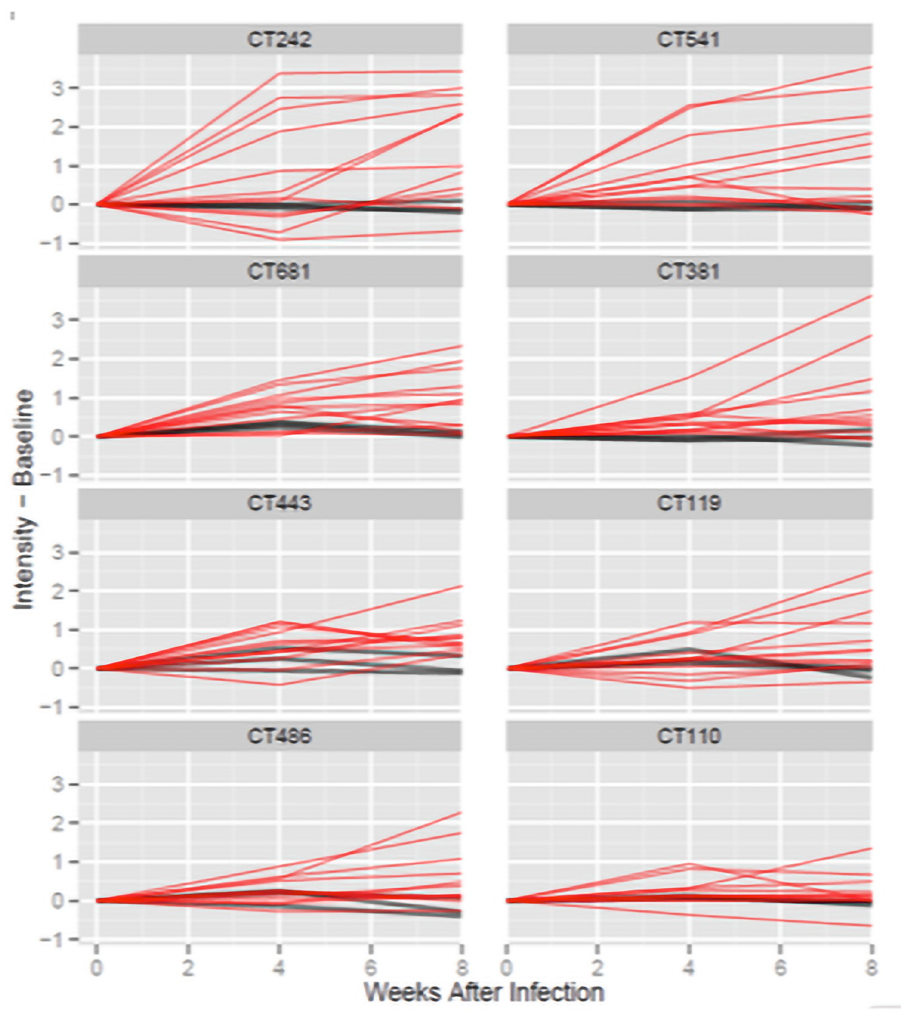
Fig 3. Time course of antibody responses from week 0 to week 8. Each panel presents the time course of antibody responses for all 15 monkeys for one reactive antigen. The x-axis indicates the weeks since infection and the y-axis shows the normalized intensity after subtracting the week 0 intensity for each monkey. Mock control monkeys are shown with dark gray lines (n = 3), and infected monkeys (n = 12) are shown with red